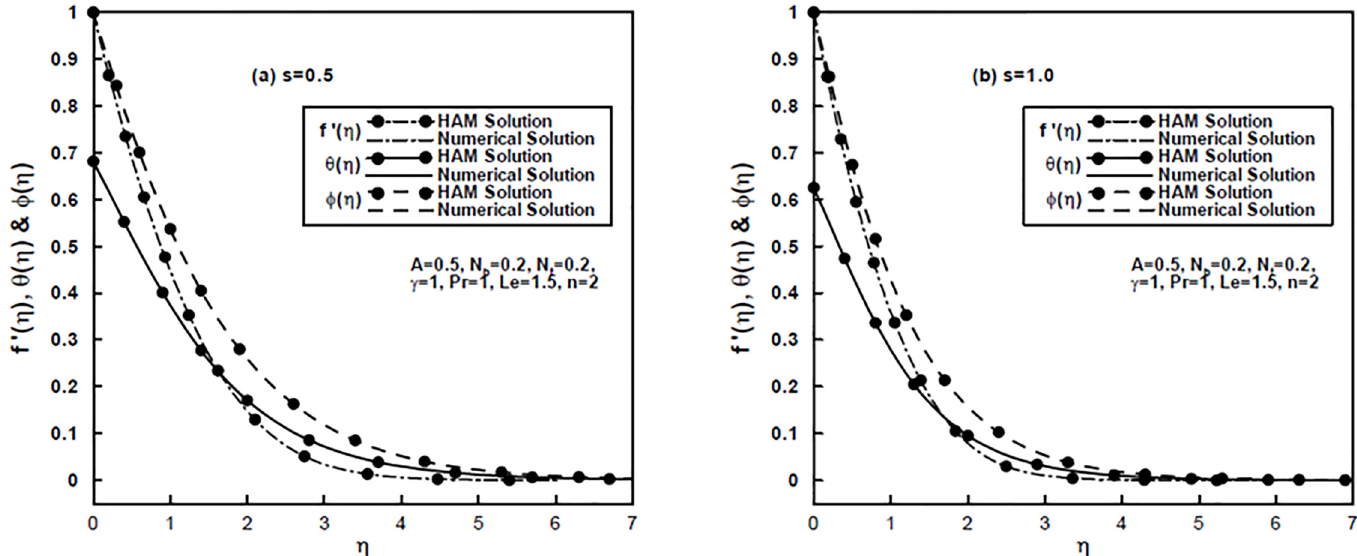
Fig 9. (a,b), A comparison of HAM solutions and numerical solutions for the velocity, temperature and concentration